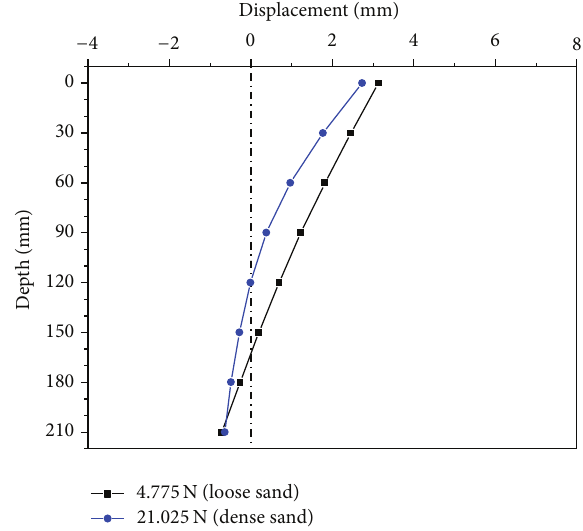
Figure4:Comparisonofthepiledeflectioninlooseanddensesand.